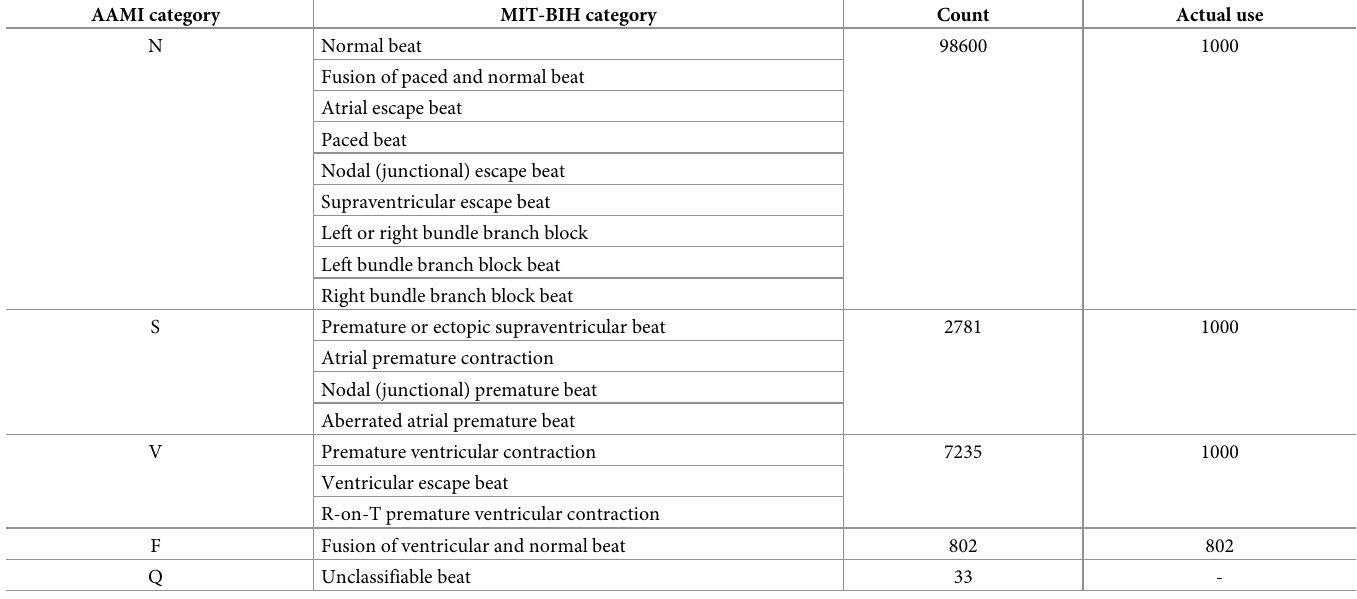
Table 1. Number of each heartbeat beat category after cutting and the actual number used